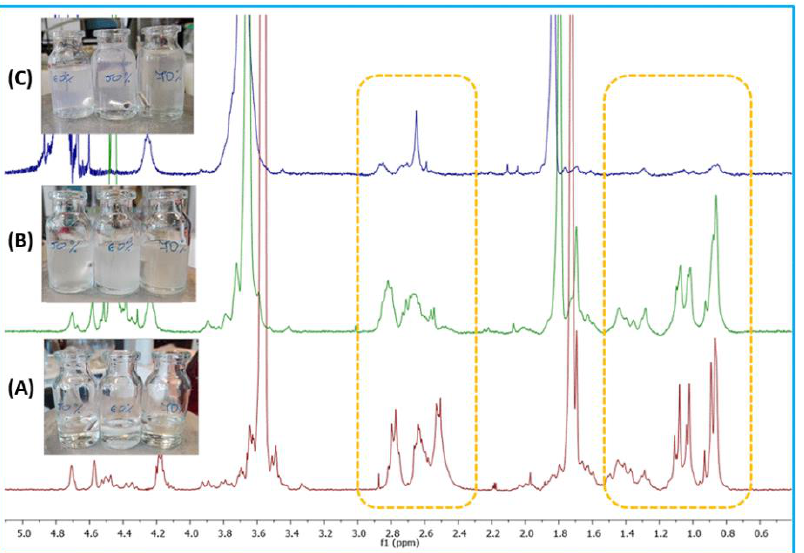
Figure 12. Micellization process observed by NMR spectroscopy: ( A ) solution of copolymer in THF; ( B ) appearance of turbidity and ( C ) opalescent solution.